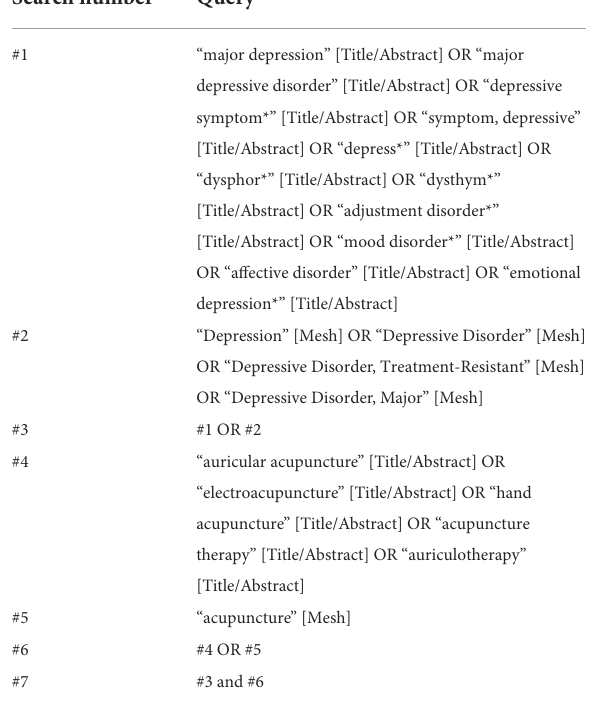
TABLE 1 Search strategy for